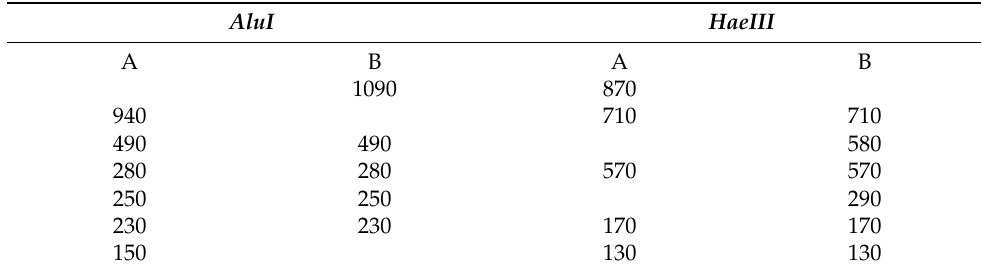
Table 2. Restriction profiles (in base pairs) after the digestion with Alu I and Hae III. Fragments with sizes smaller than 100 bp are not shown.